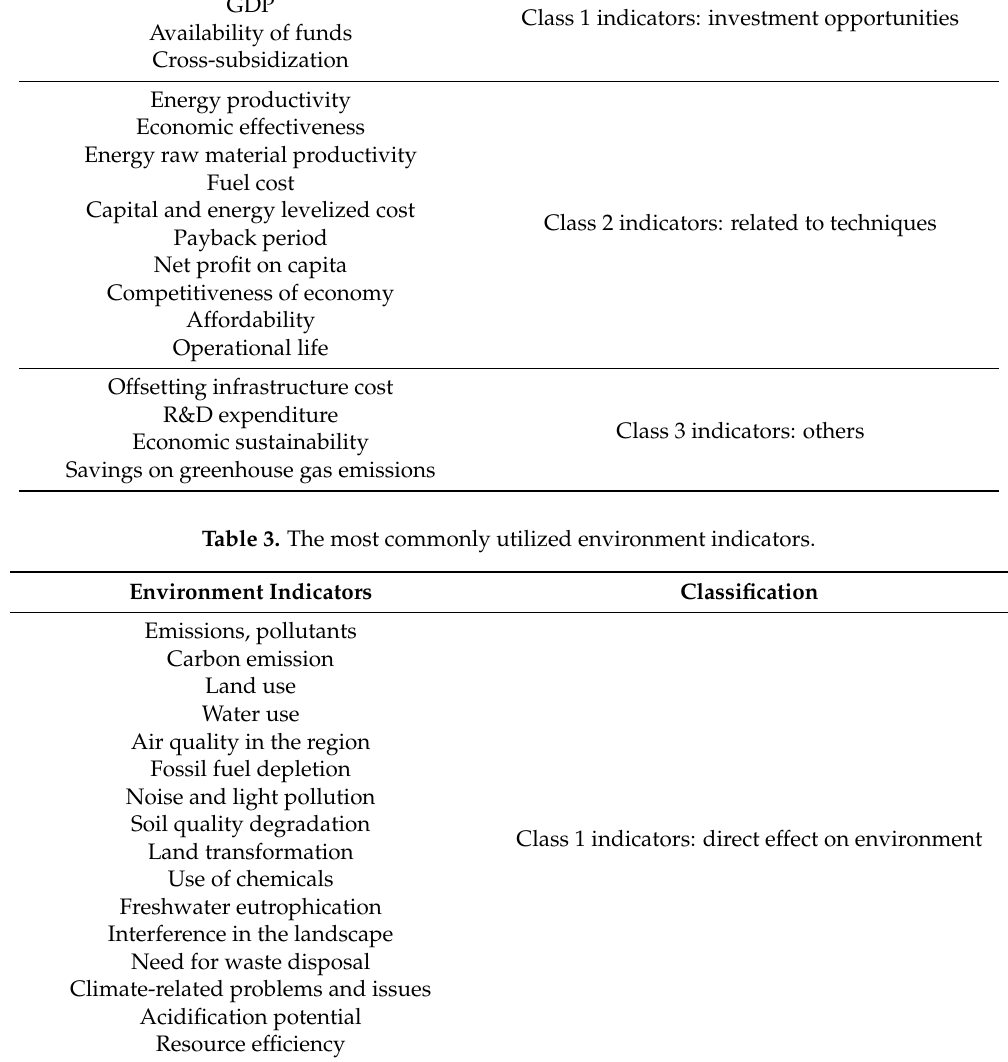
Class 3 indicators: administrative